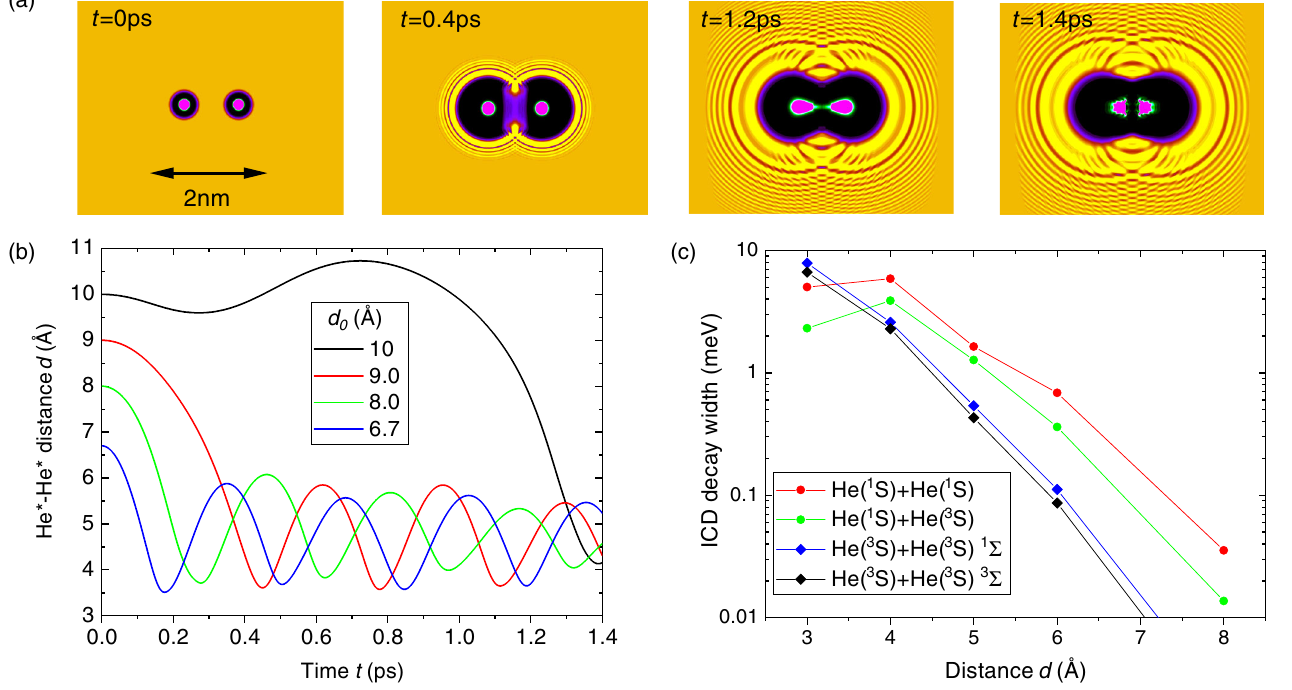
FIG. 4. (a) Snapshots of the He density evolution around two He (cid:2) centers separated initially by d 0 ¼ 10 Å. The probability distribution of He (cid:2) is represented as pink dots, and the black areas show the void bubbles forming. (b) Evolution of the He (cid:2) -He (cid:2) distance d for various values of the initial distance d 1 s 2 s -excited He (cid:2) atomic 0 . (c) Calculated ICD widths for various combinations of